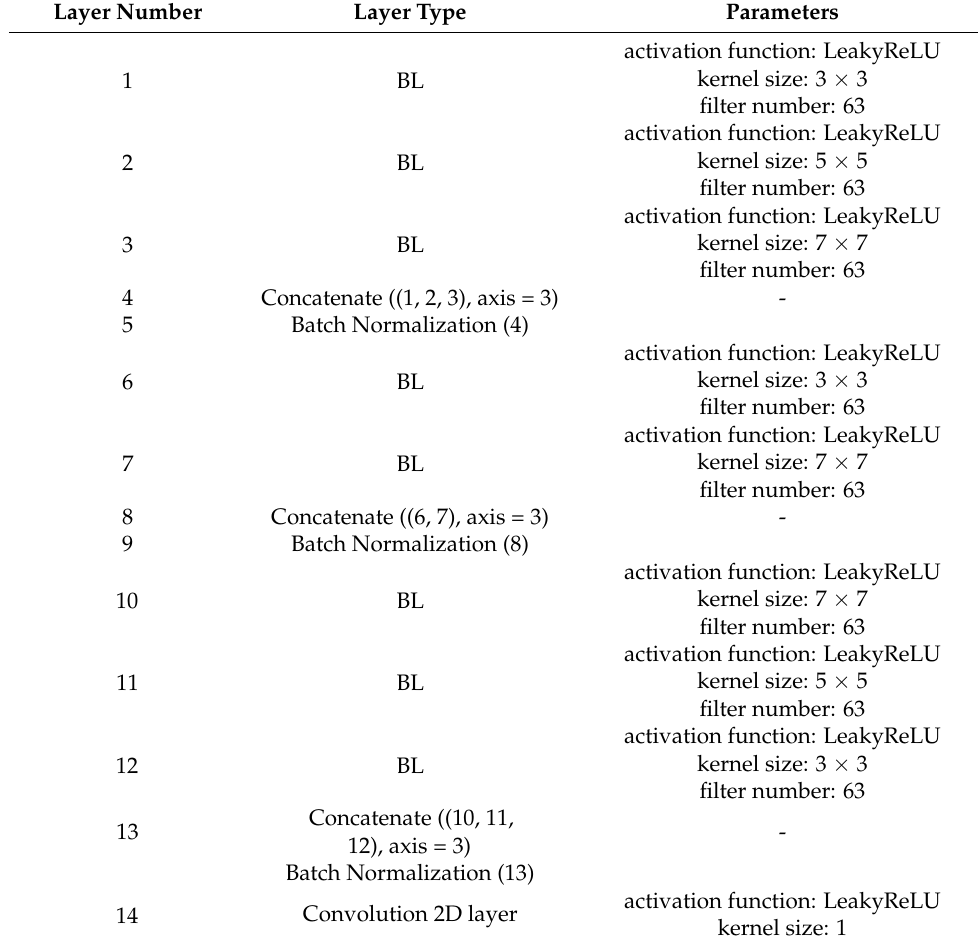
Table 4. A model of the convolutional neural network: Coding, encoding, and decoding.